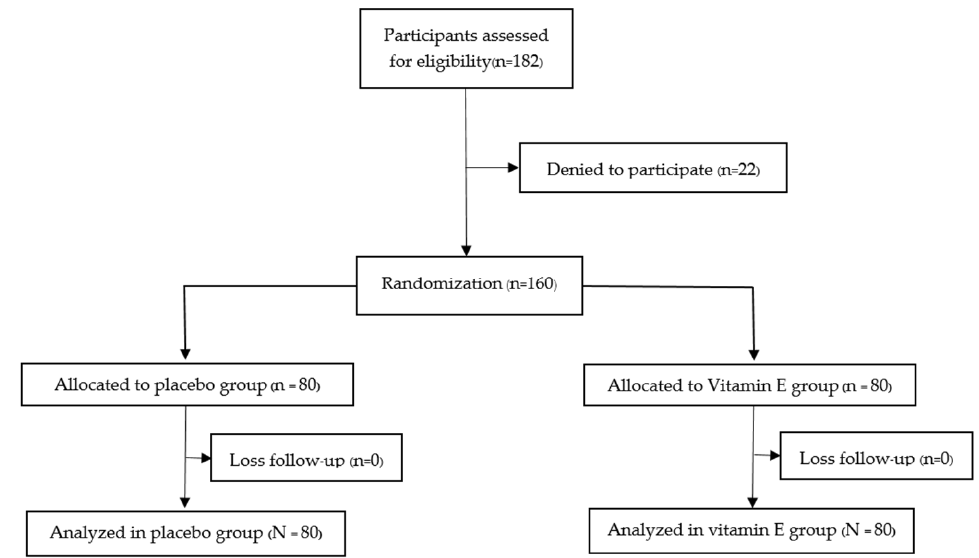
Figure 1. Protocol flow diagram of the study.